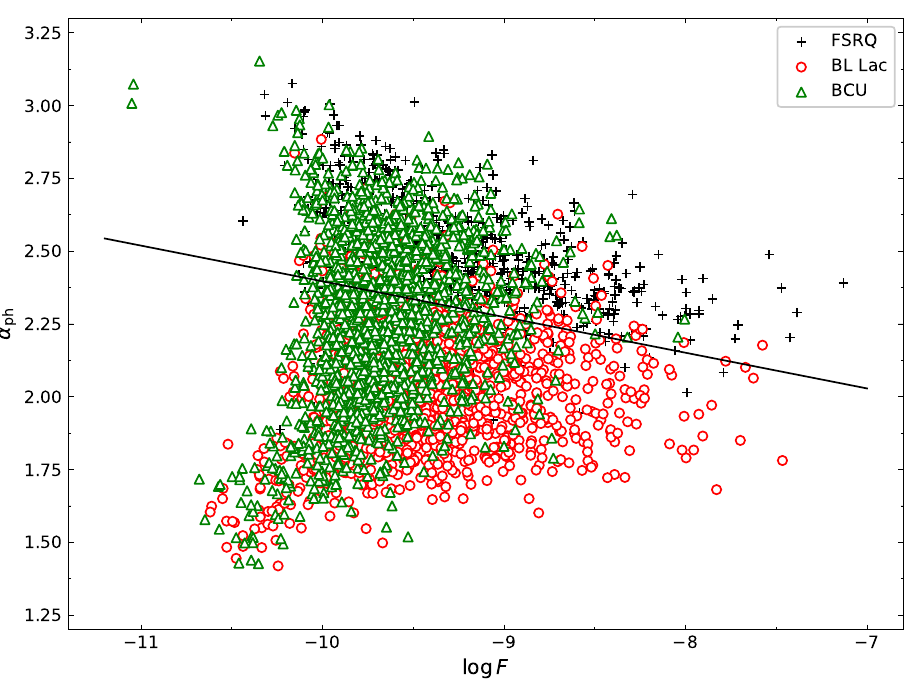
Figure 3. Plot of photon spectral index ( α ph ) against γ -ray photon flux (log F ). Open circles stand for BL Lacs, plus for FSRQs and triangle points for BCUs. The solid line ( α ph = − 0.223log F + 1.170) is obtained from the SVM method; it separates FSRQs and BL